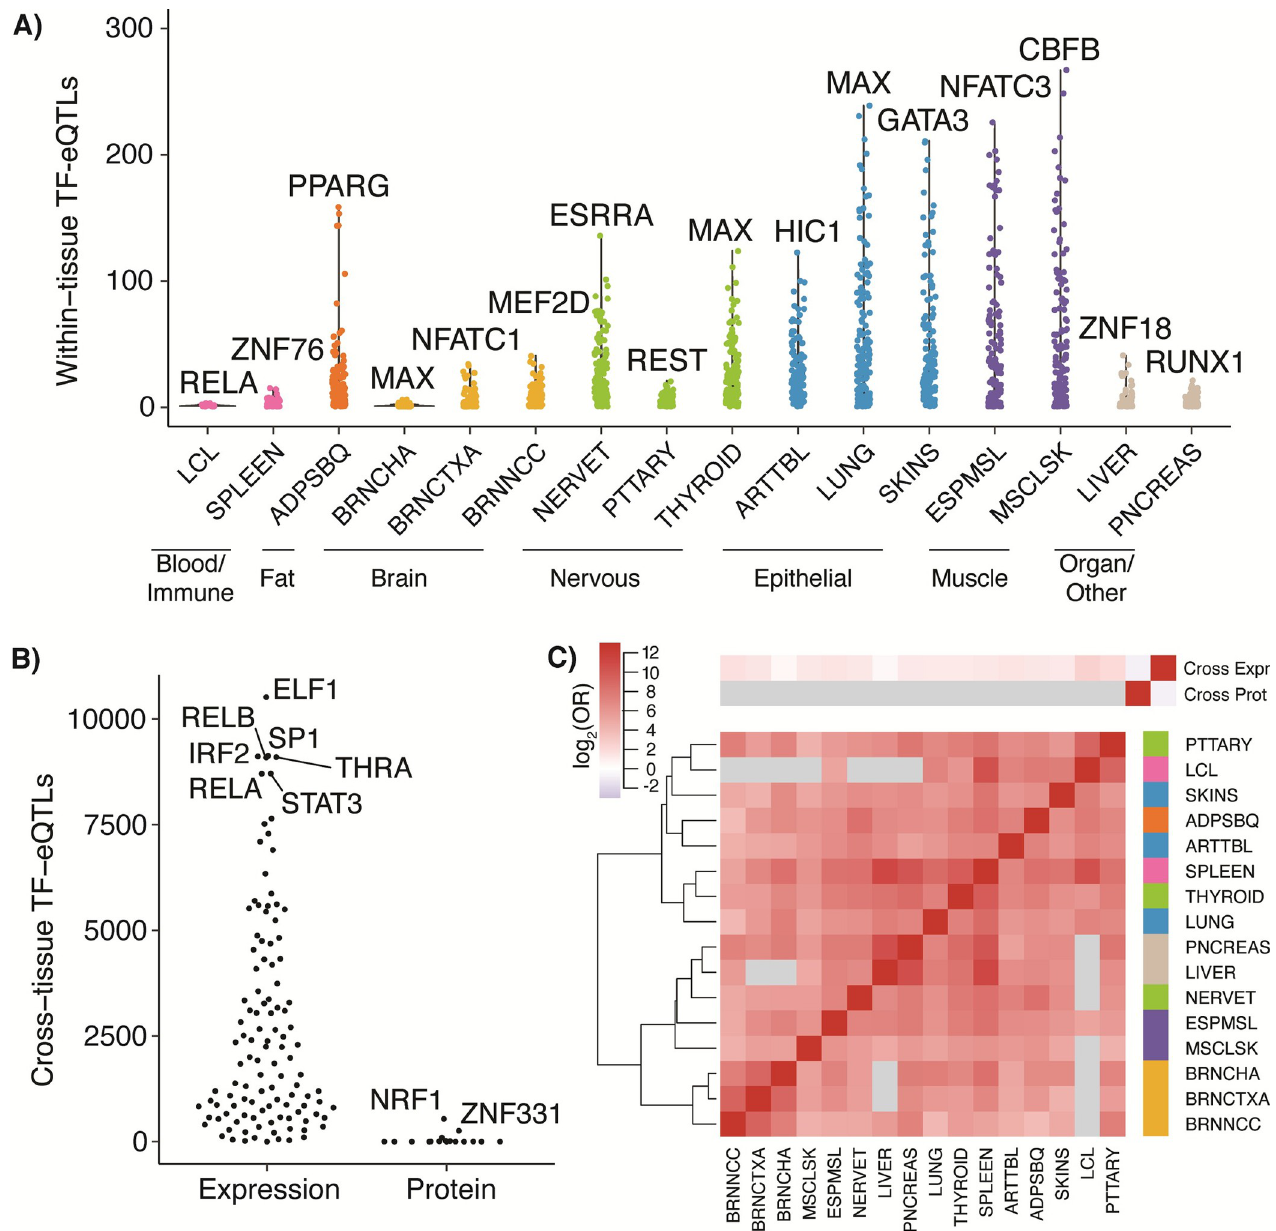
Fig 2. Discovered TF-eQTL interactions. A) Number of within-tissue TF-eQTL interactions at 5% FDR is plotted per TF for each tissue analyzed. The TF with the most interactions per tissue is highlighted. B) Number of discovered cross-tissue TF-eQTL interactions per TF for expression-based interactions and protein-based interactions (at 5% FDR). TFs with the most correlations per analysis are highlighted. C) Sharing of TF-eQTL interactions between tissues and with cross-tissue datasets. Red indicates positive enrichment and blue, negative enrichment. Grey squares indicate no shared TF-eQTL gene pairs between the two